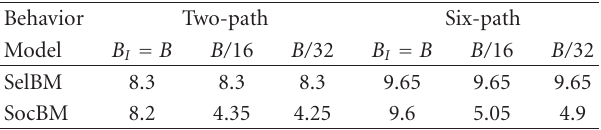
Table 1: Optimal tax rates r ∗ e ffi ciency η SE for all values of K